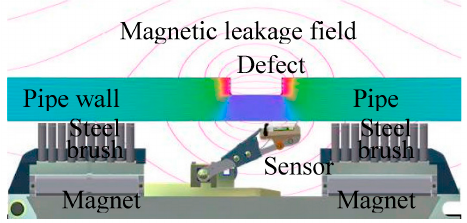
Figure 8. Schematic diagram of the magnetic flux leakage in-line inspection principle.